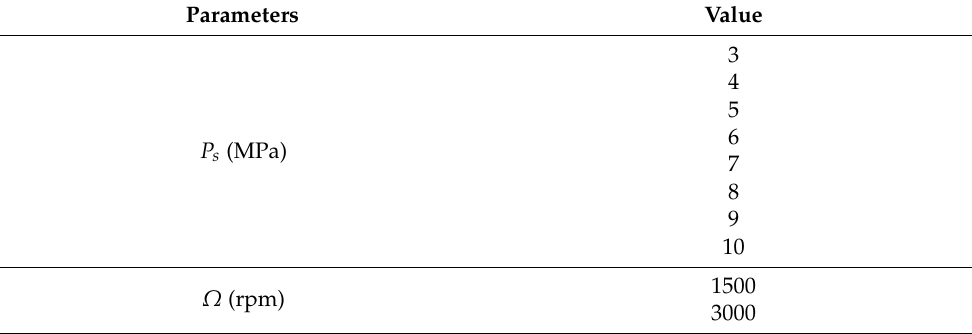
Table 5. Working parameters of the system.